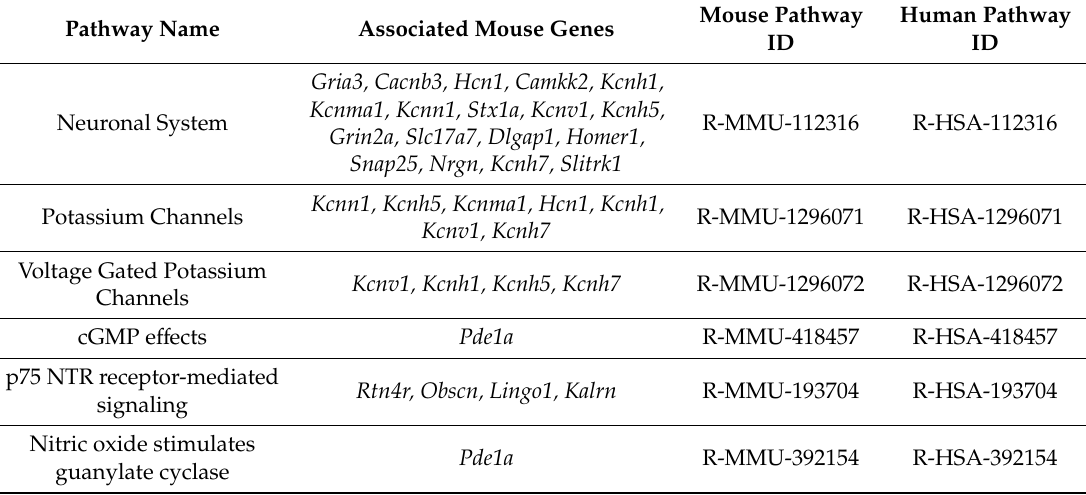
Table 3. Combination of LDR and HLU versus controls DEG and Reactome pathway IDs in mice that translated to human